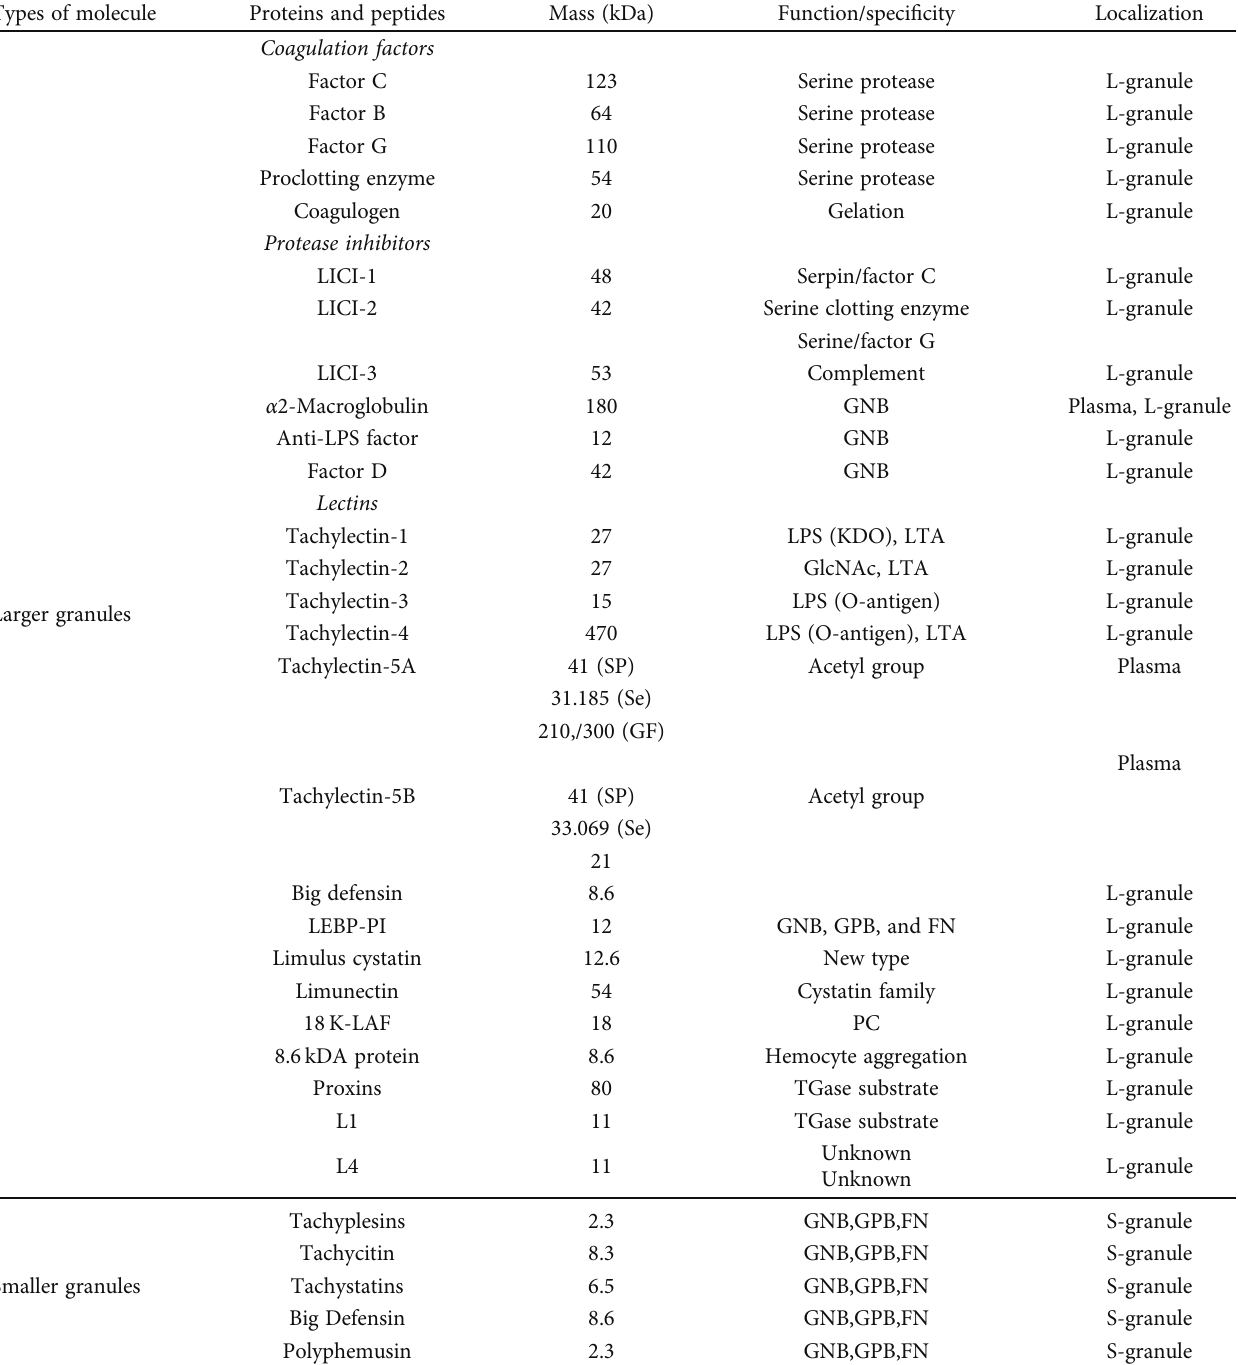
Table 3: Biomolecules exist in horseshoe crab hemolymph and hemocytes